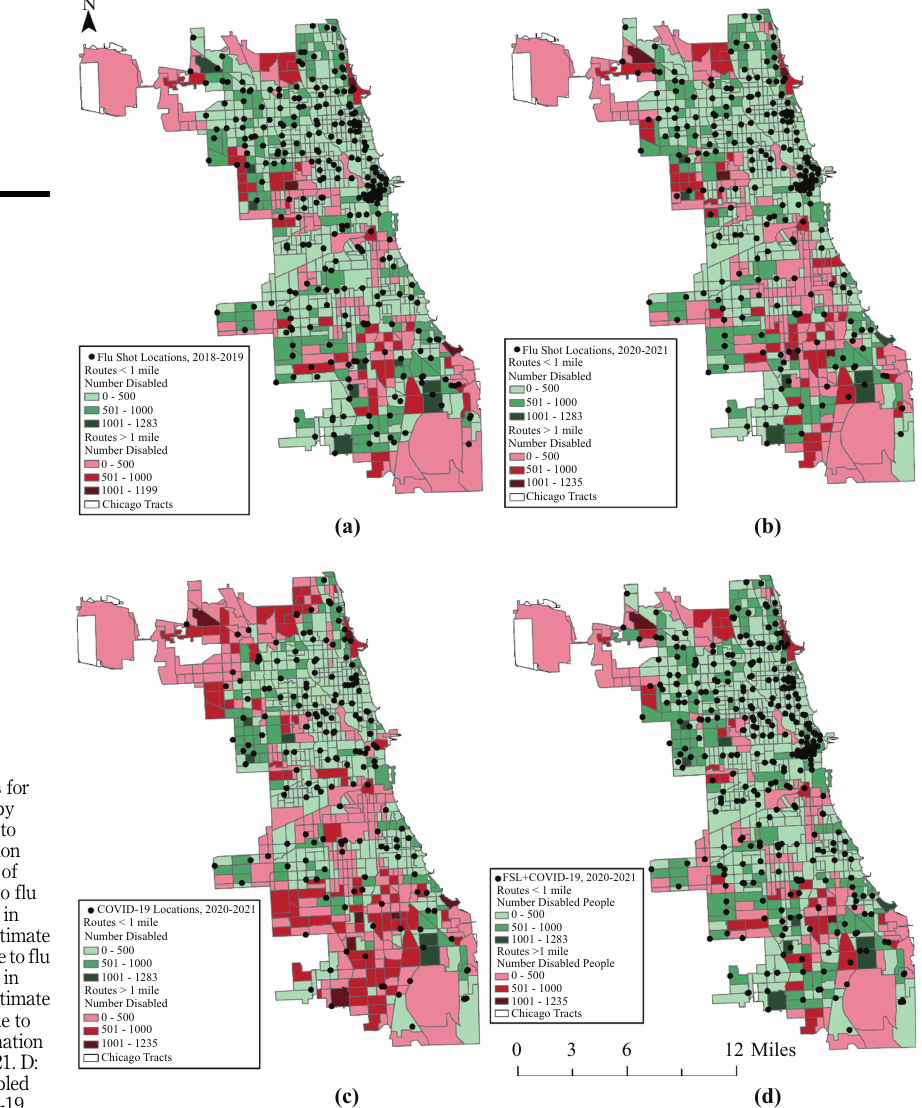
51.6% of the city ’ s elderly located within one mile of a COVID-19 vaccination site. Figure 1D shows that by combining the 2020 – 2021 flu shot locations with COVID-19 flu shot locations, access improves from 51.6% of the elderly being within a mile to a vaccination site to 75.1%. Minimizing the driving distance to the vaccination sites does not resolve the physical and